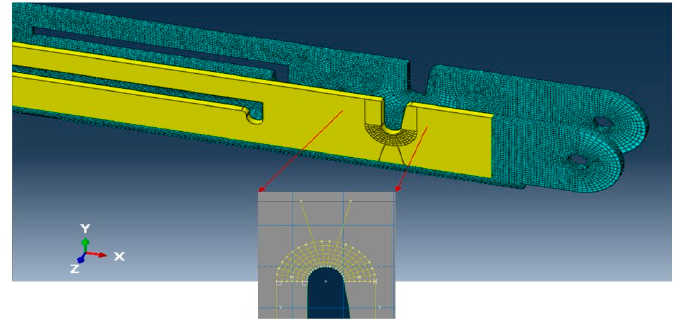
Figure 23. Advanced meshing application.